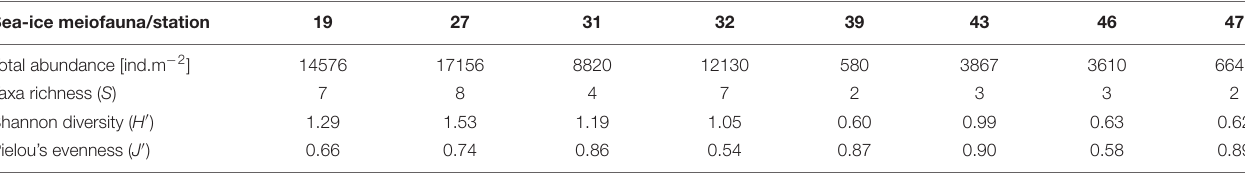
TABLE 2 | List of total abundances and biodiversity indices for sea-ice meiofauna per station. Sea-ice meiofauna/station